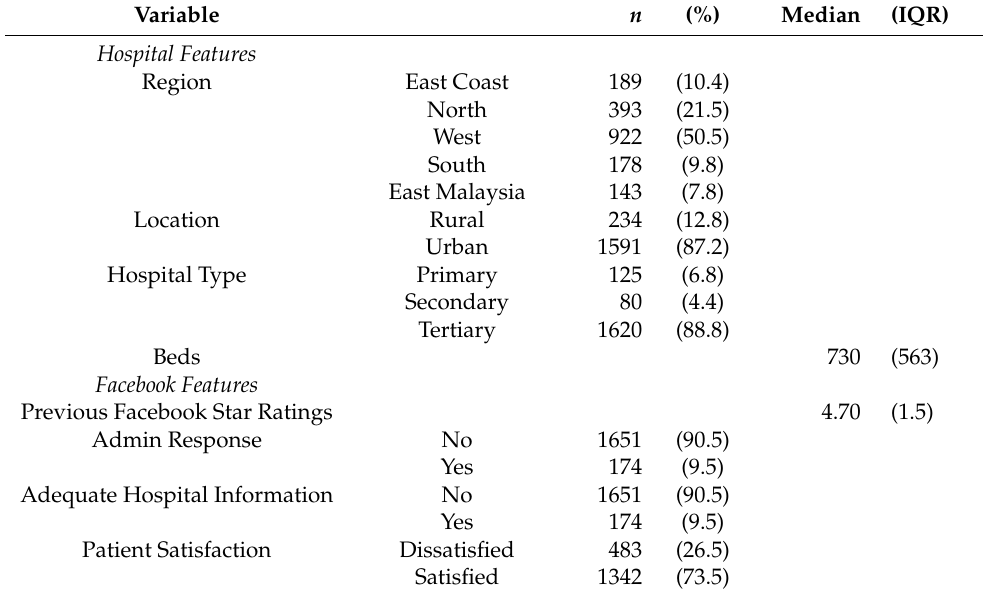
Table 2. Hospital Facebook review characteristics ( n =